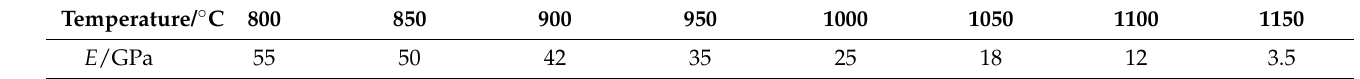
Table 3. Determination of elastic modulus E values of Cr5 steel at different